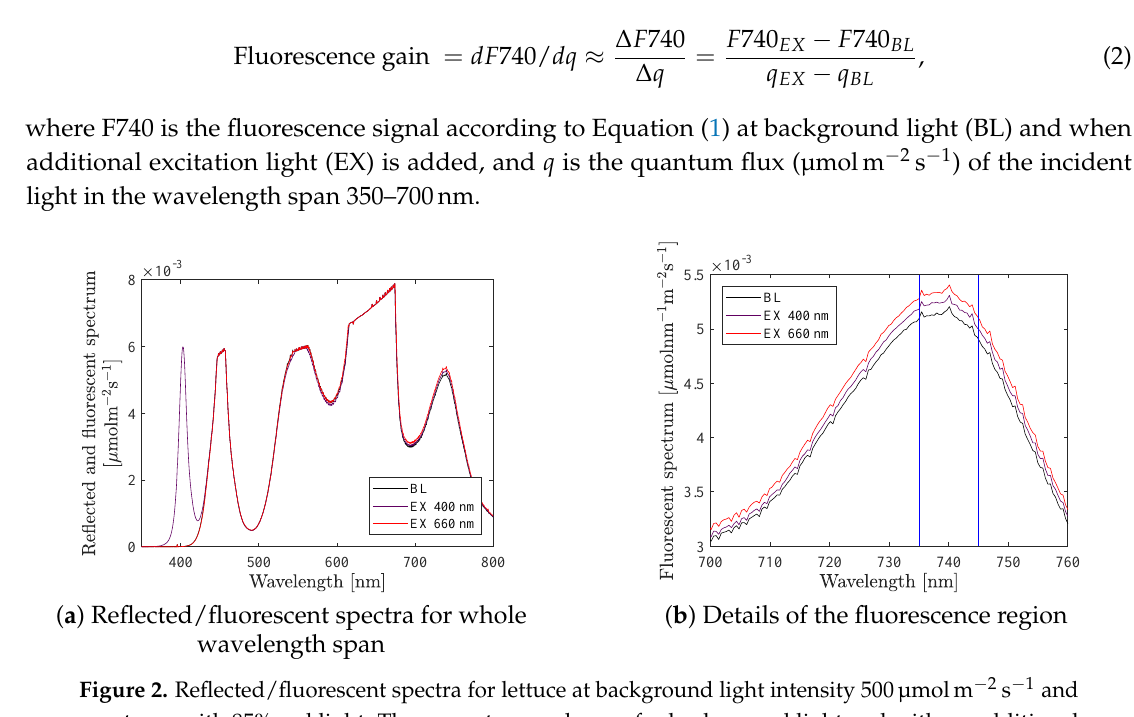
Figure 2. Reflected/fluorescent spectra for lettuce at background light intensity 500µmolm − 2 s − 1 and spectrum with 85% red light. Three spectra are shown; for background light and with an additional excitation signal with light emitting diode (LED) 400 and LED 660 respectively. Vertical lines in plot ( b ), indicate the region where the spectrum is integrated to get the F740 signal according to Equation